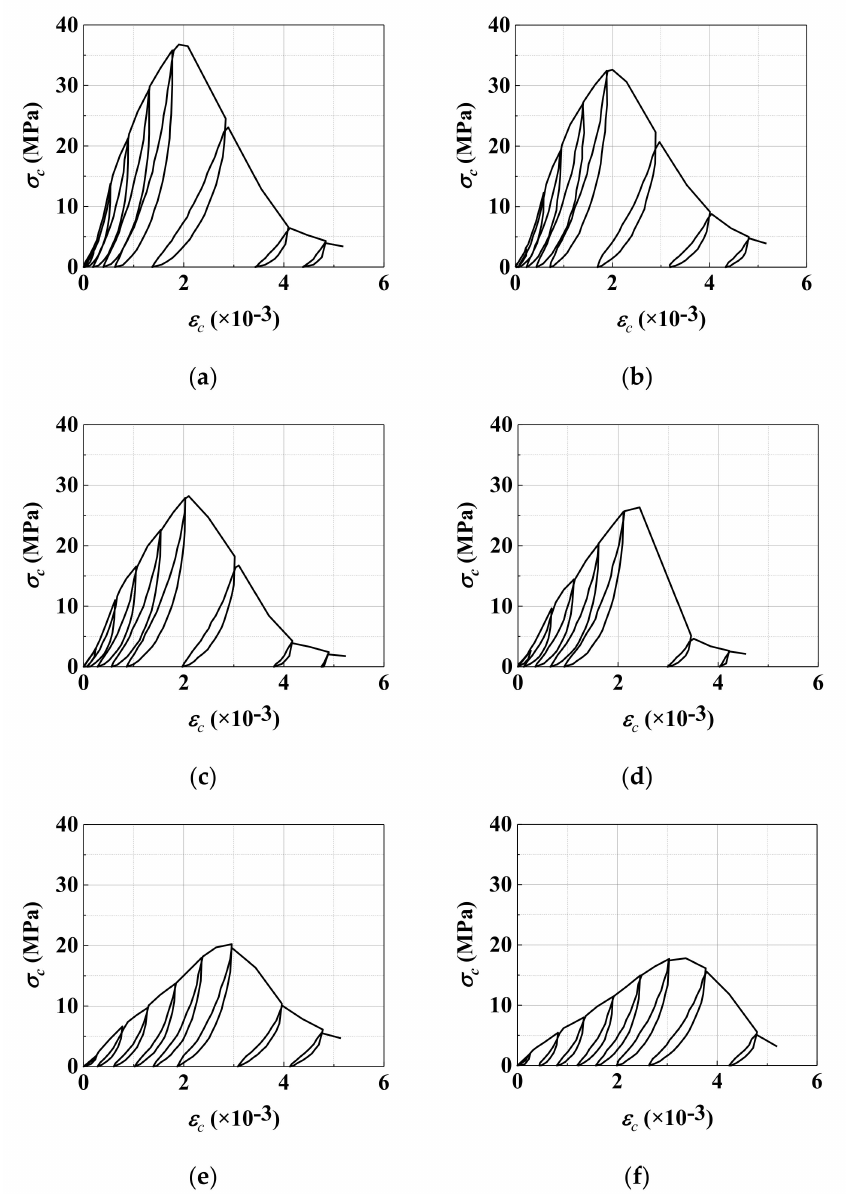
Figure 6. Uniaxial repeated compression test results. ( a ) N = 0. ( b ) N = 25. ( c ) N = 50. ( d ) N = 75. ( e ) N = 100. ( f ) N =